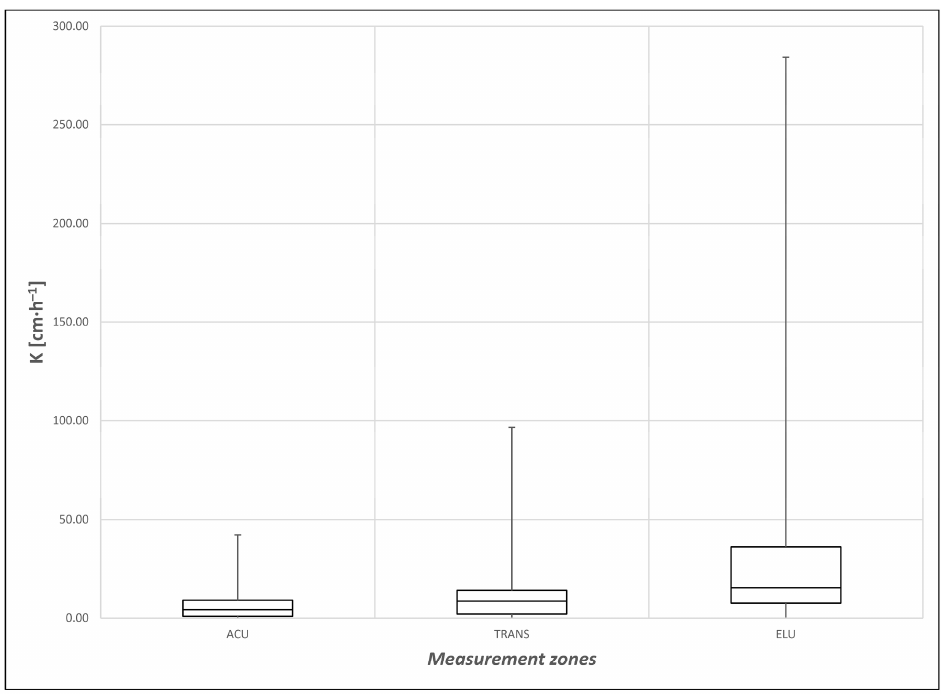
Figure 4. Values of saturated hydraulic conductivity in measurement zones.